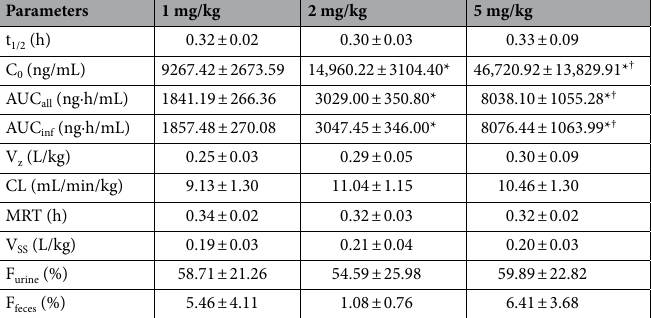
Table 1. Average non-compartmental pharmacokinetic parameters and excretion ratio of 175 Lu-DOTA- PSMA-GUL after intravenous injection in rats (n = 5–7). *p < 0.05 vs. 1 mg/kg; † p < 0.05 vs. 2 mg/kg.